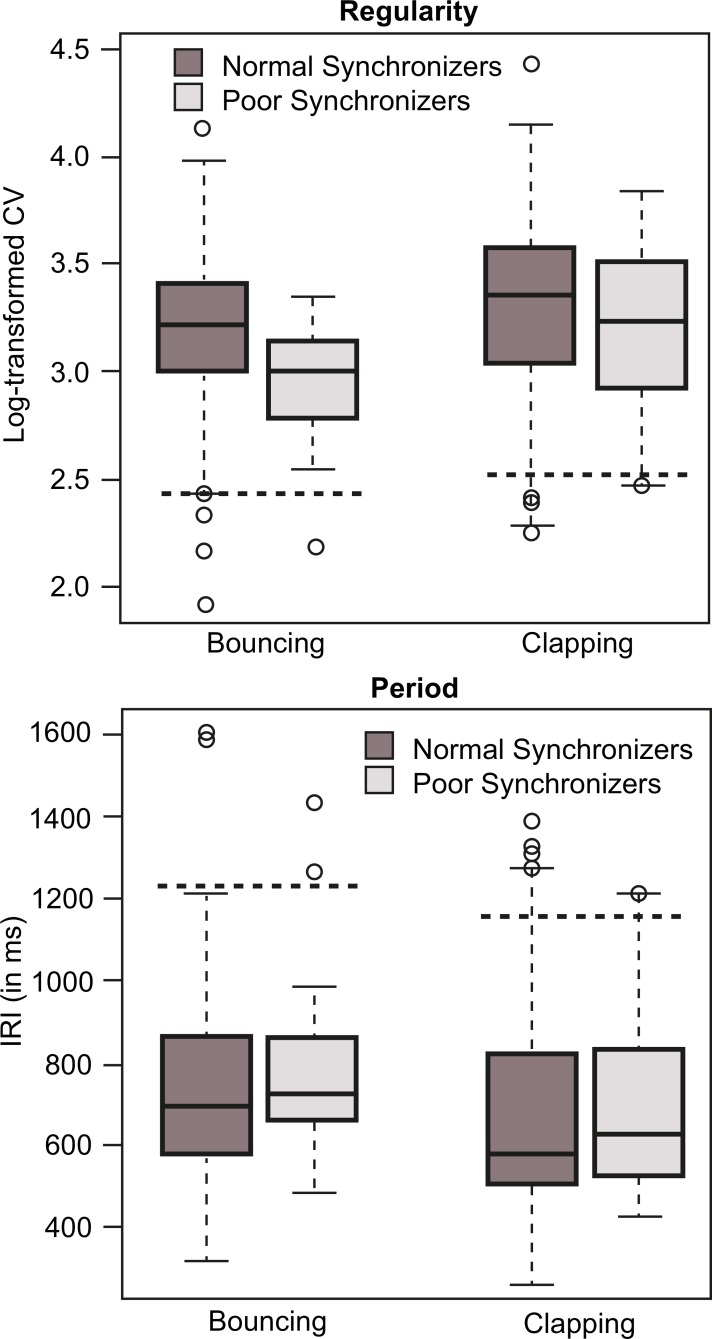
Self-paced motor production.We present produced period (mean inter-bounce/clap-intervals) and regularity (coefficient of variation) in Normal Synchronizers and Poor Synchronizers. For period, dotted horizontal lines show 2 SD above the mean (there were no participants performing below 2 SD below the mean). For regularity, dotted horizontal lines show 2 SD below the mean (i.e. extremely low regularity). Circles indicate outliers (2 SD from the mean).